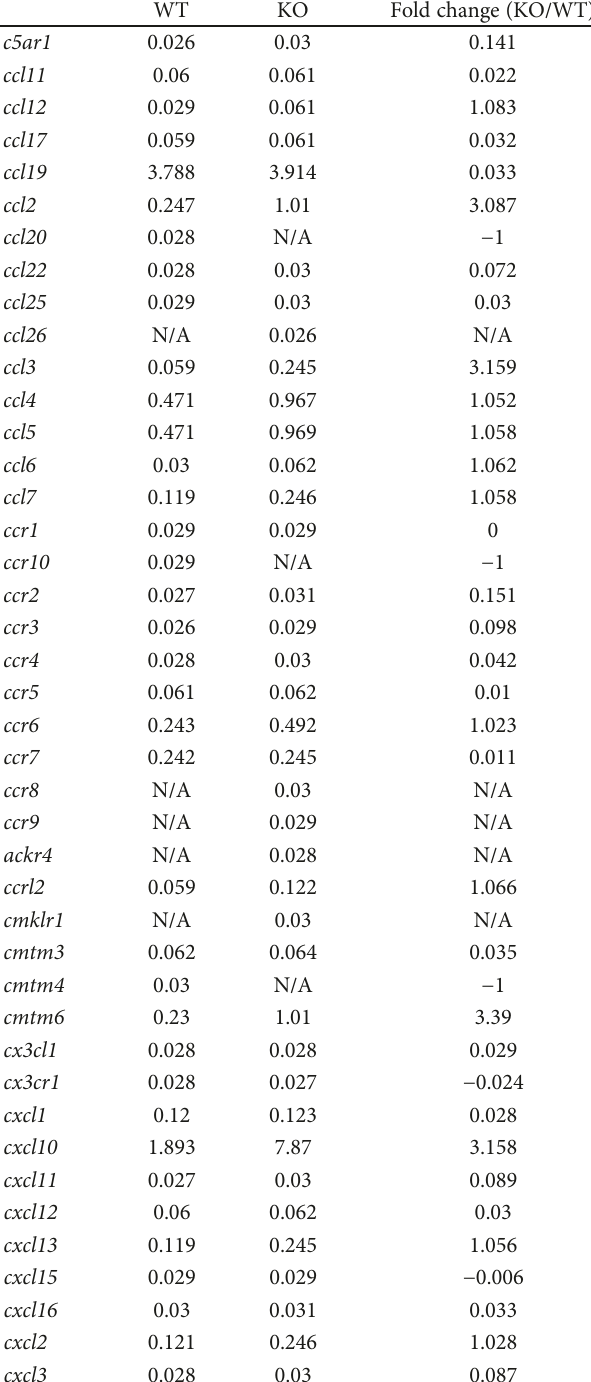
Table 2: Chemokine and receptor mRNA expression in spleens of wild-type and CB knockout mice. Male C57BL/6J mice (8 – 10 2 weeks old) were administered with 1mg/kg LPS for 2 hours and were sacri fi ced to harvest spleens. The tissues were homogenised, RNA was extracted and reverse transcribed to cDNA. Pooled cDNA from 9 wild-type or CB knockout mice was used in 2 murine chemokine and receptor PCR arrays. Data are normalised to endogenous Gapdh levels and presented as 2^( − Δ